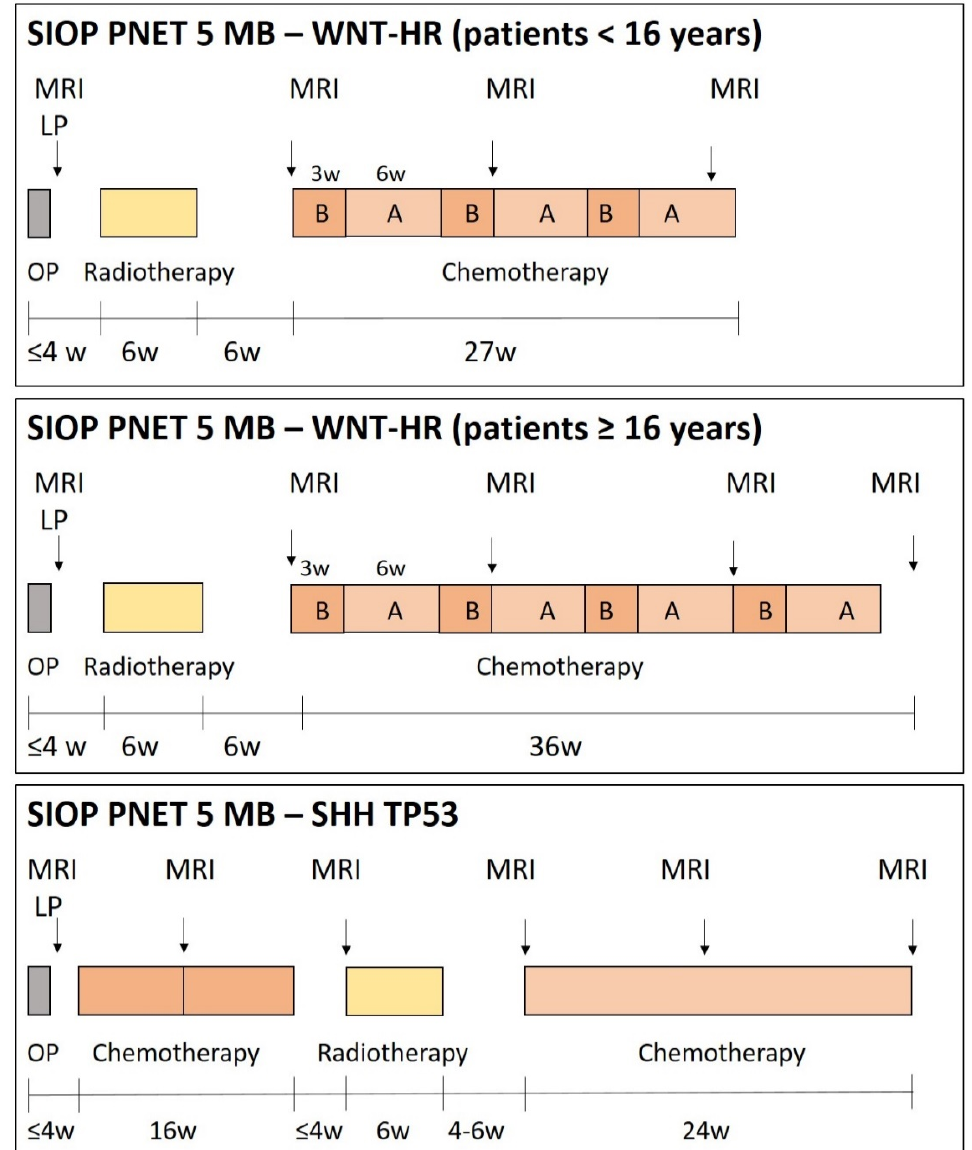
Figure 3. Therapy overview SIOP PNET5-WNT-HR and SHH-TP53 strata. After surgery (OP),